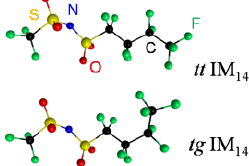
Figure 2. Equilibrium geometry of the two lowest energy IM 14 conformers, tt IM 14 and tg IM 14 , as obtained by DFT calculations.